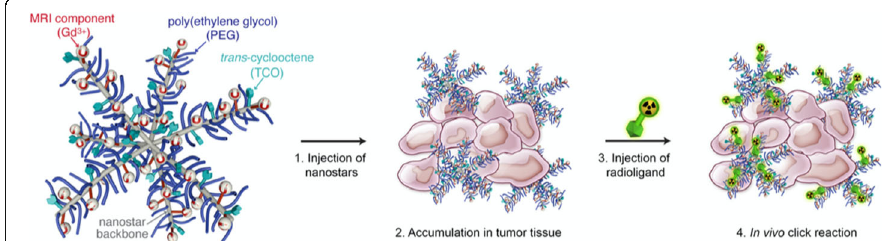
Fig. 2 TCO-functionalized nanostars passively accumulate at the tumor site. After several days, a radioligand is injected that will bind to the TCO-functionalized nanostars at the tumor site via the bioorthogonal IEDDA click reaction. Unreacted radioligands are cleared from the blood circulation rapidly (within hours), resulting in minimal radiation doses to off-target tissues. (Reprinted from Goos et al. (2020), with permission from